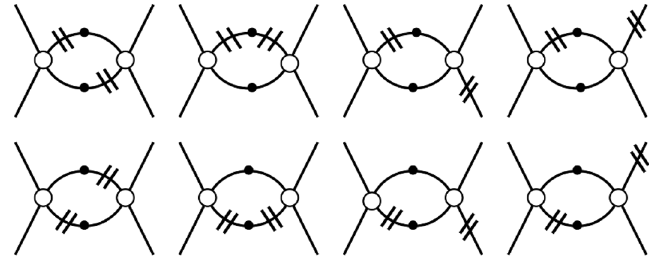
Figure 11 . Set of 1-loop integrals from the double-trace Lagrangian contributing to the amplitude A ∂ 2 ∂ 2